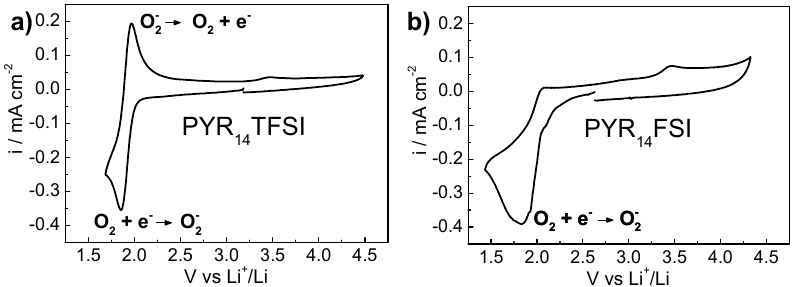
Figure 1. Voltamperogram at 20 mV s − 1 of ( a ) N -butyl- N -methylpyrrolidinium bis(trifluoromethanesulfonyl)imide (Pyr Glassy carbon; Counter electrode: Pt wire; Reference electrode: Ag +